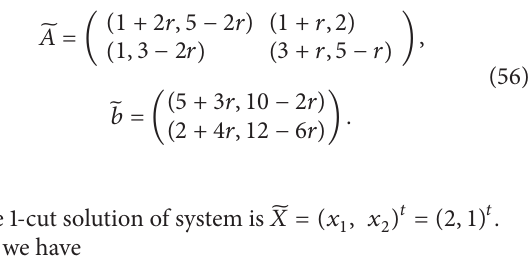
Figure 2: Compare and ̃𝑥 +,𝑙,𝑢 𝐺 ( ◻ ).